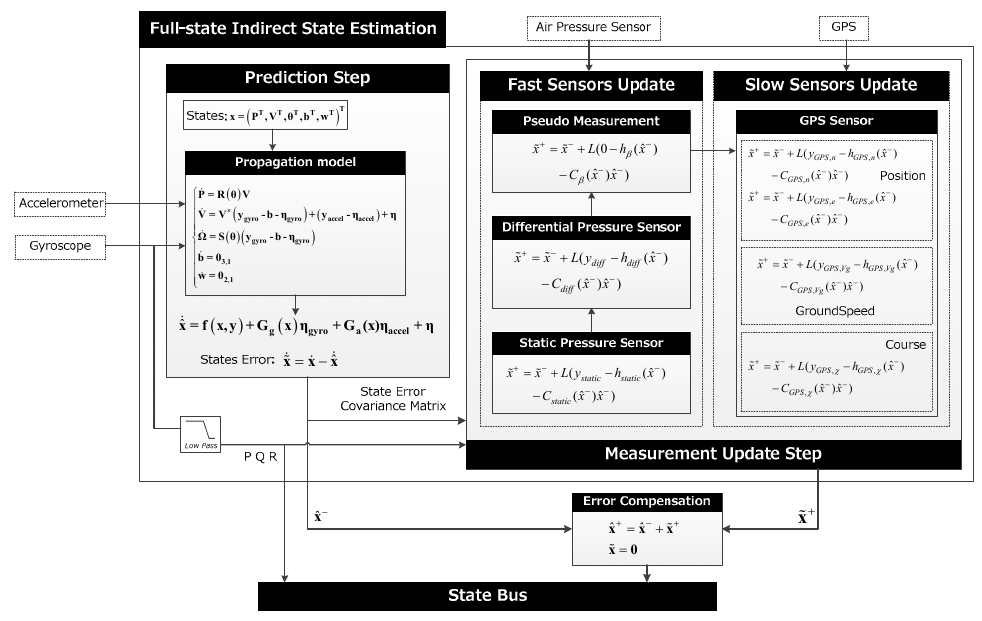
Figure 10. Full ‐ state indirect state estimation structure. Figure 10. Full-state indirect state estimation